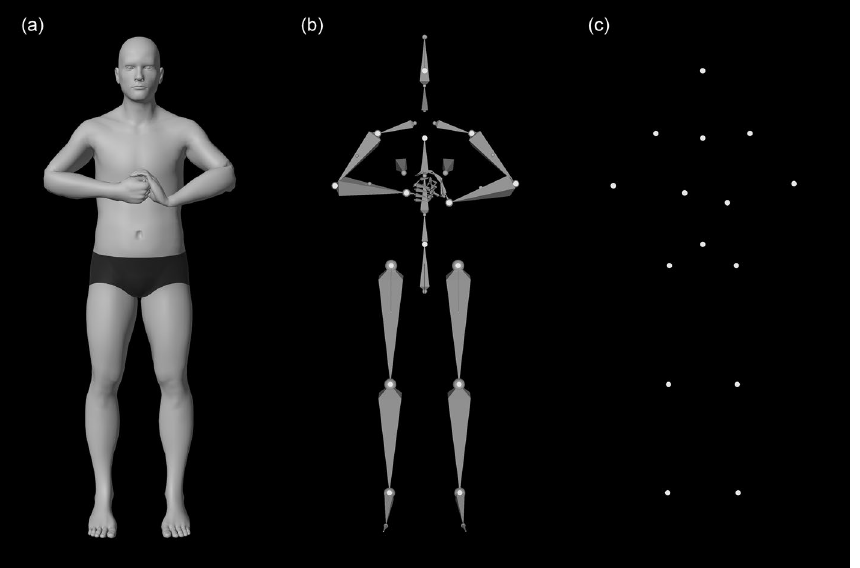
Figure 2. Detailed view of the 3D humanoid model used to create the final EmBody stimuli (point-light displays). The model consists of a human body ( a ), an animatable underlying skeleton ( b ), and the white spheres used to create the resulting point-light displays ( c